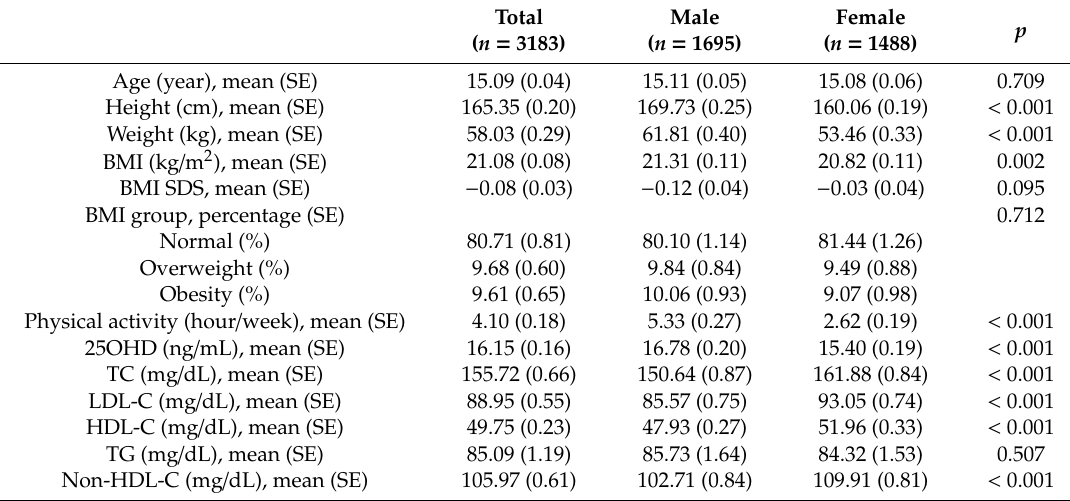
Table 1. Baseline characteristics of